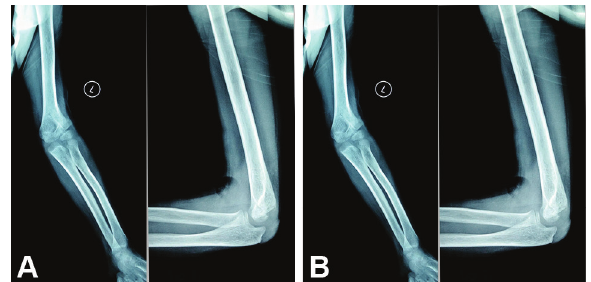
Figure 2. (A) Postoperative radiographs showing the reduction of a fixation. (B) The follow up radiographs showing united fracture and stable